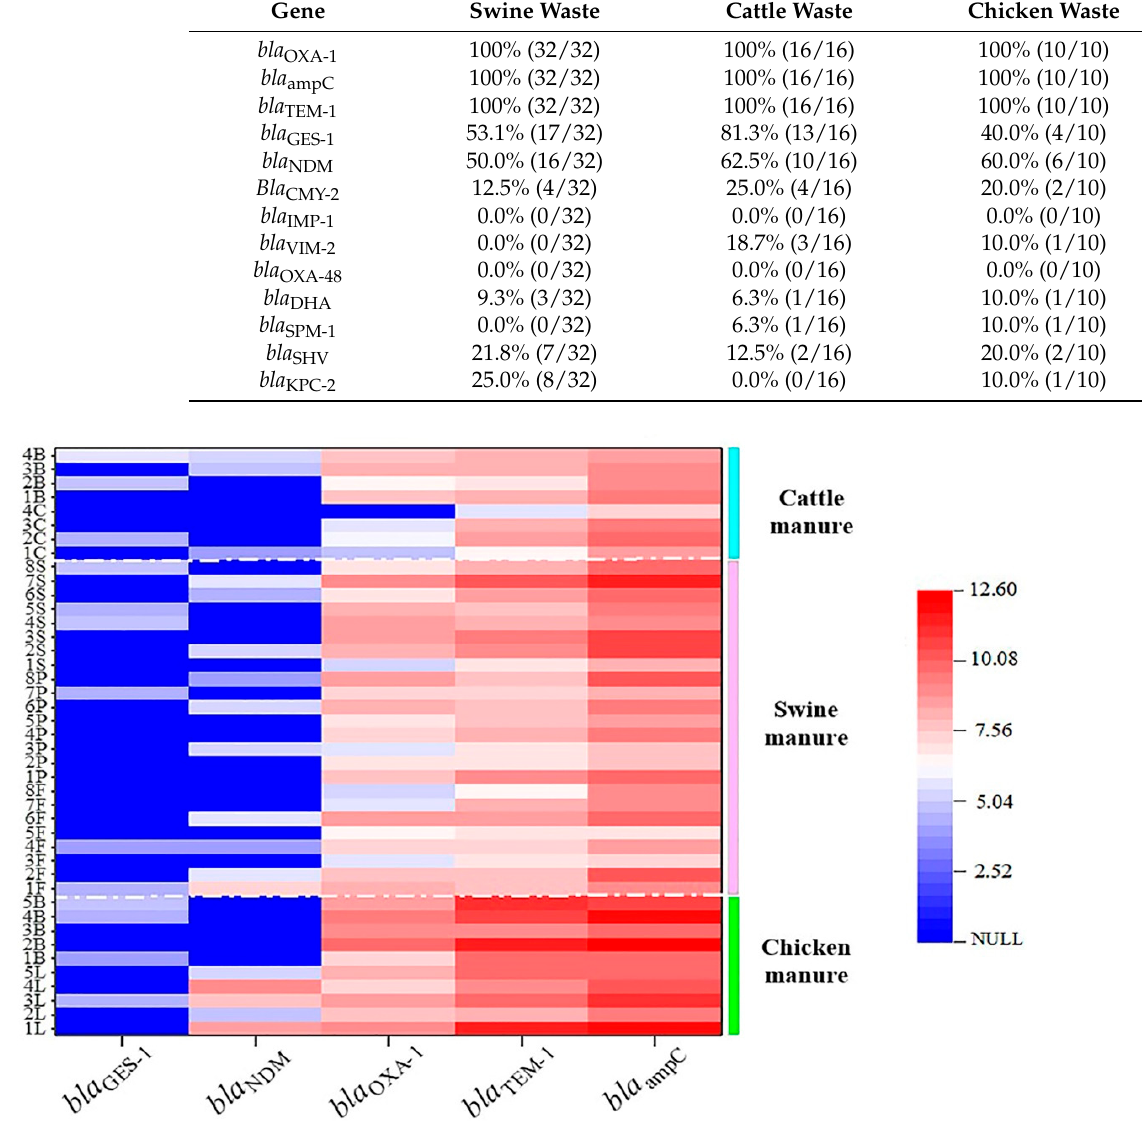
Figure 2. Heat maps of the abundance of bla genes in the family livestock manure. Abbreviations (from top to bottom): B—beef cow manure; C—dairy cow manure; S—sow manure; P—piglet manure; F—fattening pig manure; B—broiler chicken manure; L—layer chicken manure; 1–8—serial number of farm; NULL—no